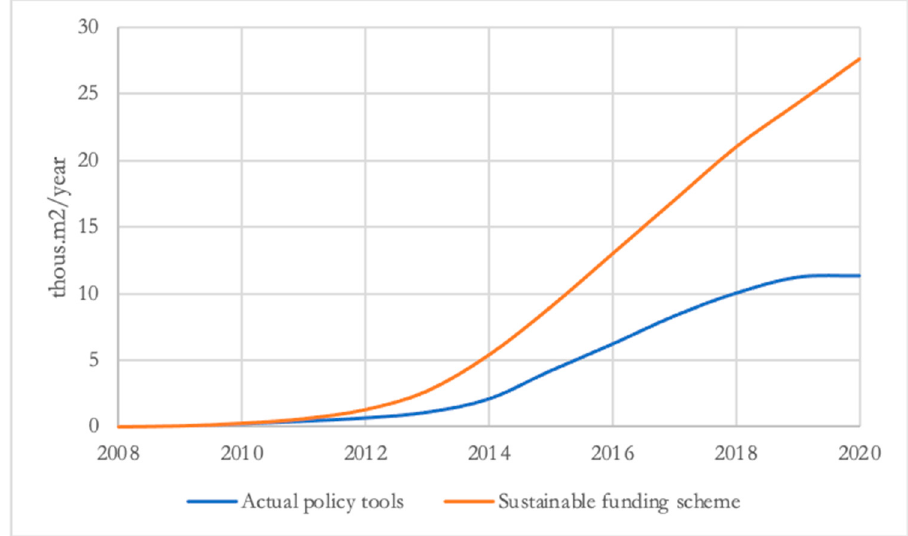
Figure 22. Simulated word-of-mouth effect with actual policy tools and with sustainable EU funding scheme and penalty–reward scheme in force.